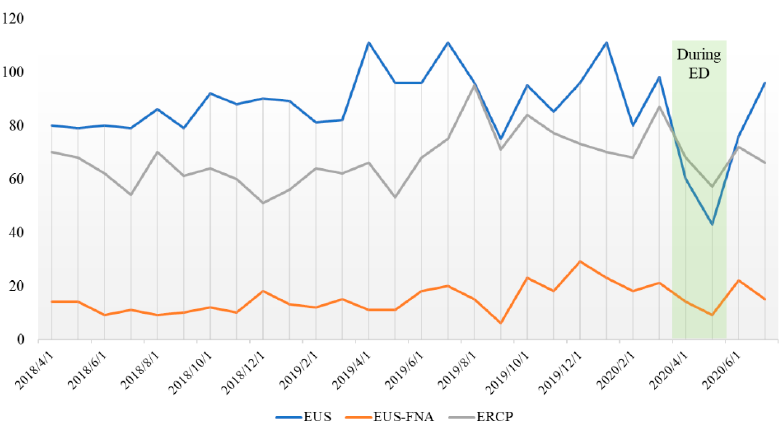
Figure 2. The number of pancreaticobiliary endoscopies decreased. The rate of EUS was significantly reduced by 42.7%, and that of EUS-FNA was reduced by 23.3% between during and before the ED.